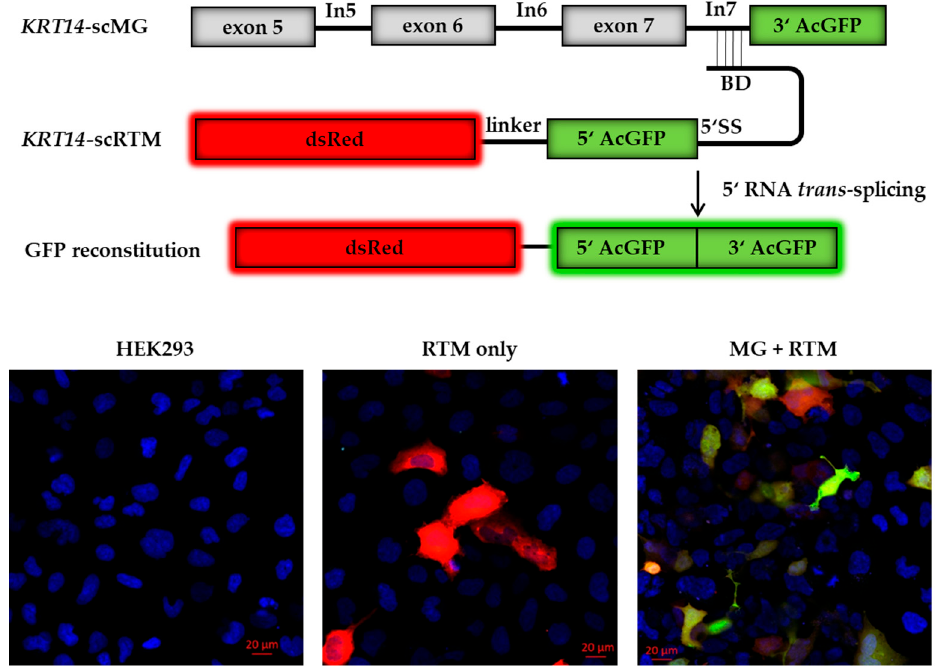
Figure 2. Screening constructs for antisense molecule selection. The reporter-based screening system consists of an artificial KRT14 screening minigene ( KRT14 -scMG), containing the KRT14 target region spanning from exon 5 to intron 7 and the 3 ′ part of GFP, and the RTM screening vector ( KRT14 -scRTM) carrying a dsRed reporter molecule and the missing 5 ′ GFP part, splicing elements for efficient splicing and a binding domain specific for intron 7 of KRT14 . Accurate trans -splicing between the KRT14 -scMG and the KRT14 -scRTM (red) restores the GFP expression (green) in the cell manifested in a yellow signal. Cell nuclei were 4 ′ ,6-diamidin-2-phenylindol (DAPI) stained (blue). BD, binding domain; 5 ′ SS, 5 ′ splice site.